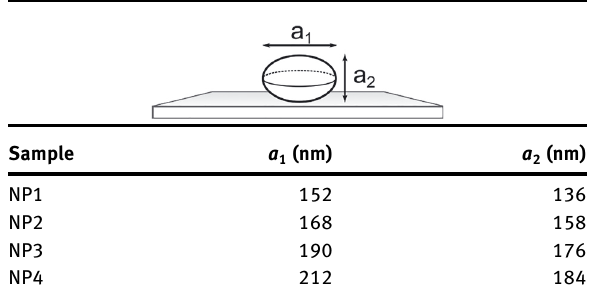
Table 1: Parameters of the studied nanoparticles (NP) used in the simulations: a 1 is the equatorial diameter of the spheroid, a 2 is the polar diameter.